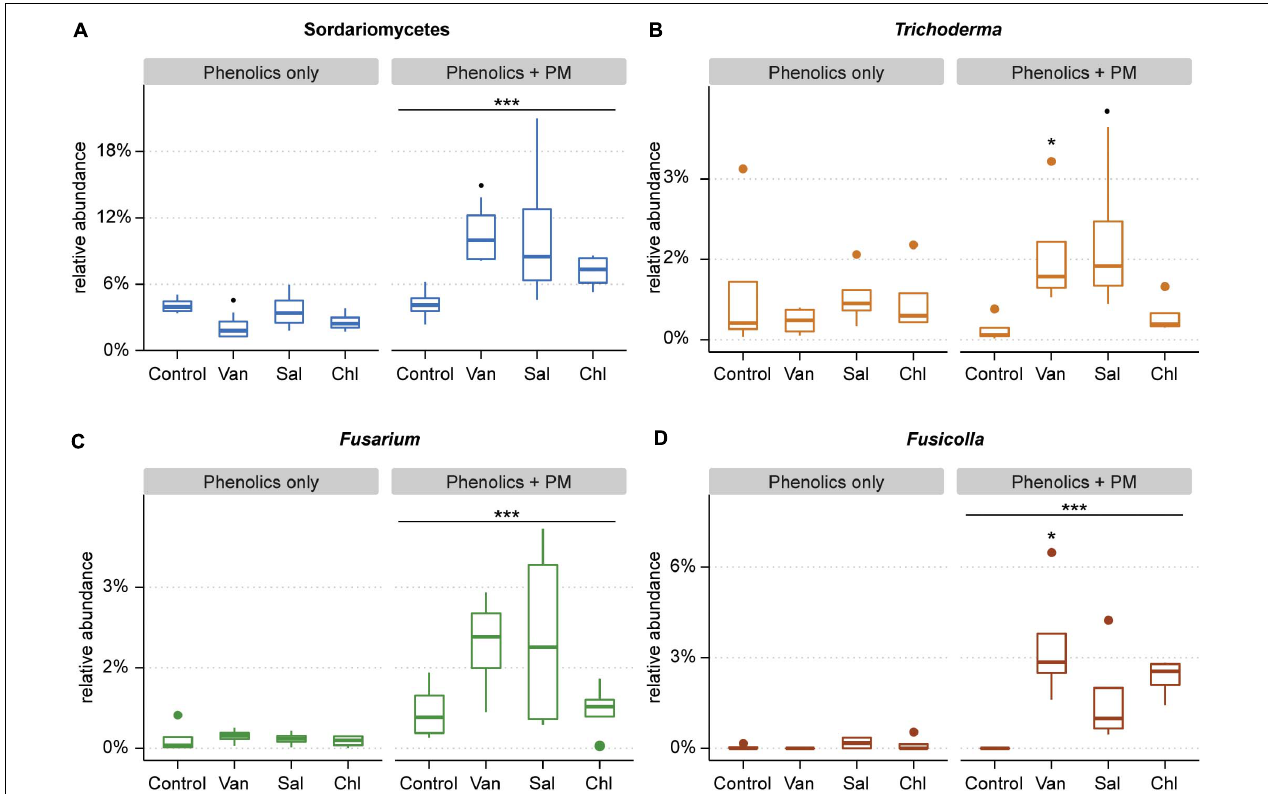
FIGURE 7 | Relative abundance of Sordariomycetes (A) and the three most abundant sordariomycetal genera: Trichoderma (B) , Fusarium (C) , and Fusicolla (D) , as found in the soil compartment of in rhizosphere simulation microcosms treated with vanillic acid (Van), salicylic acid (Sal), chlorogenic acid (Chl) or control, with and without primary metabolites (PM). The main effect of primary metabolites is shown, as well as the effect of a phenolic acid as compared to the control ( • 0.1 > p > 0.05, *0.05 > p > 0.01, *** p <